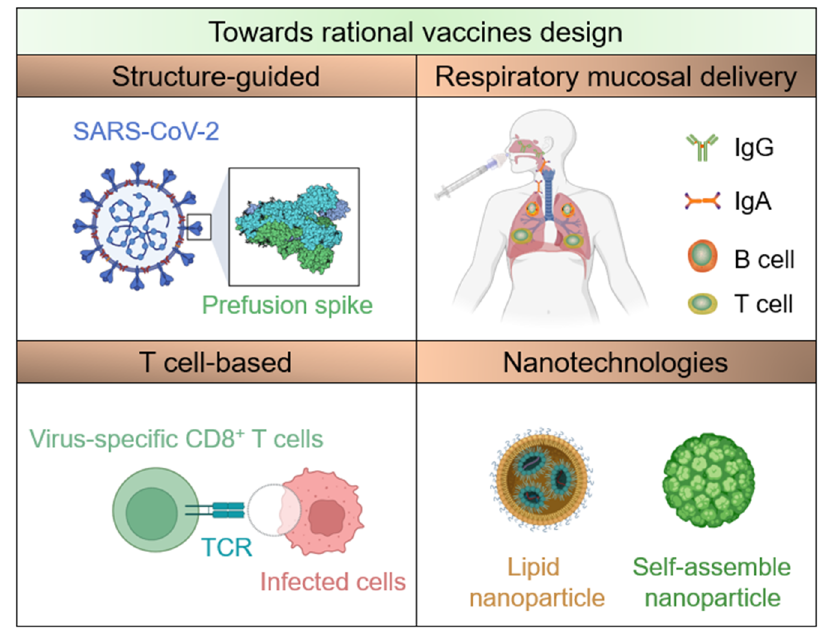
Scheme 1. Insights towards rational vaccine design. Typical approaches involved in the COVID-19 vaccine candidates are discussed, including structure-guided vaccine design, T-cell-based vaccines, respiratory mucosal delivery, and enabled nanotechnologies. A schematic diagram is involved in illustrating each